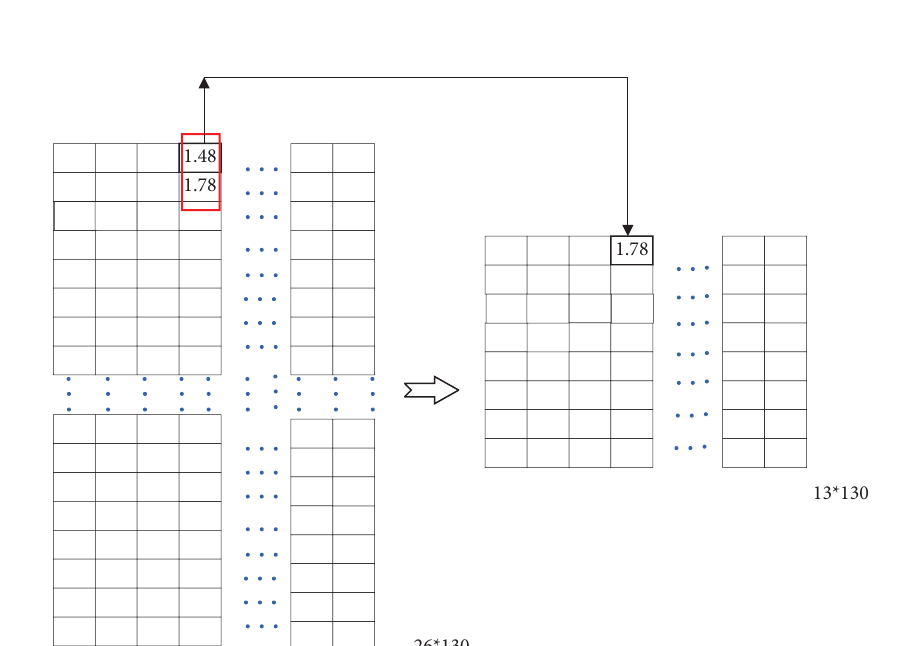
Figure 8: Max-pooling